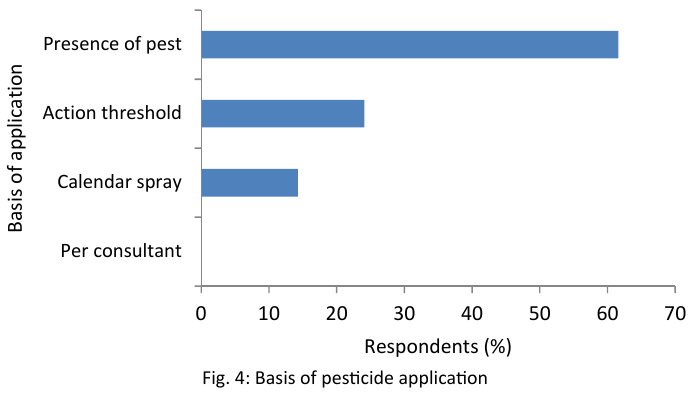
Fig. 4: Basis of pesticide application Table 5: Most commonly used pesticides in rice farming in the selected barangay of three municipalities Pesticide